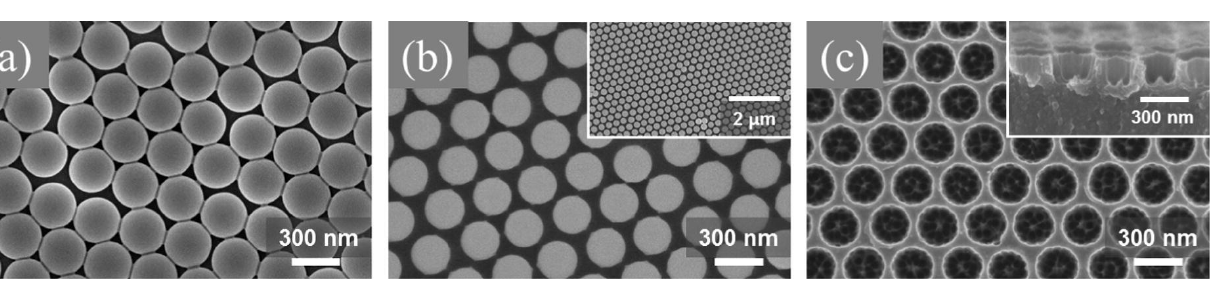
Figure 5. SEM images during nanoporous SU-8 substrate fabrication. ( a ) A monolayer of polystyrene nanoparticles on the SU-8 substrate, ( b ) etched polystyrene nanoparticles on the SU-8 substrate and the inset showing uniformly etched PS nanoparticles over the SU-8 substrate, and ( c ) fabricated nanopores on the surface of SU-8 and the inset showing the cross-sectional view of the nanoporous SU-8 substrate. Reprinted from Kim et al. [50] with permission from Elsevier.